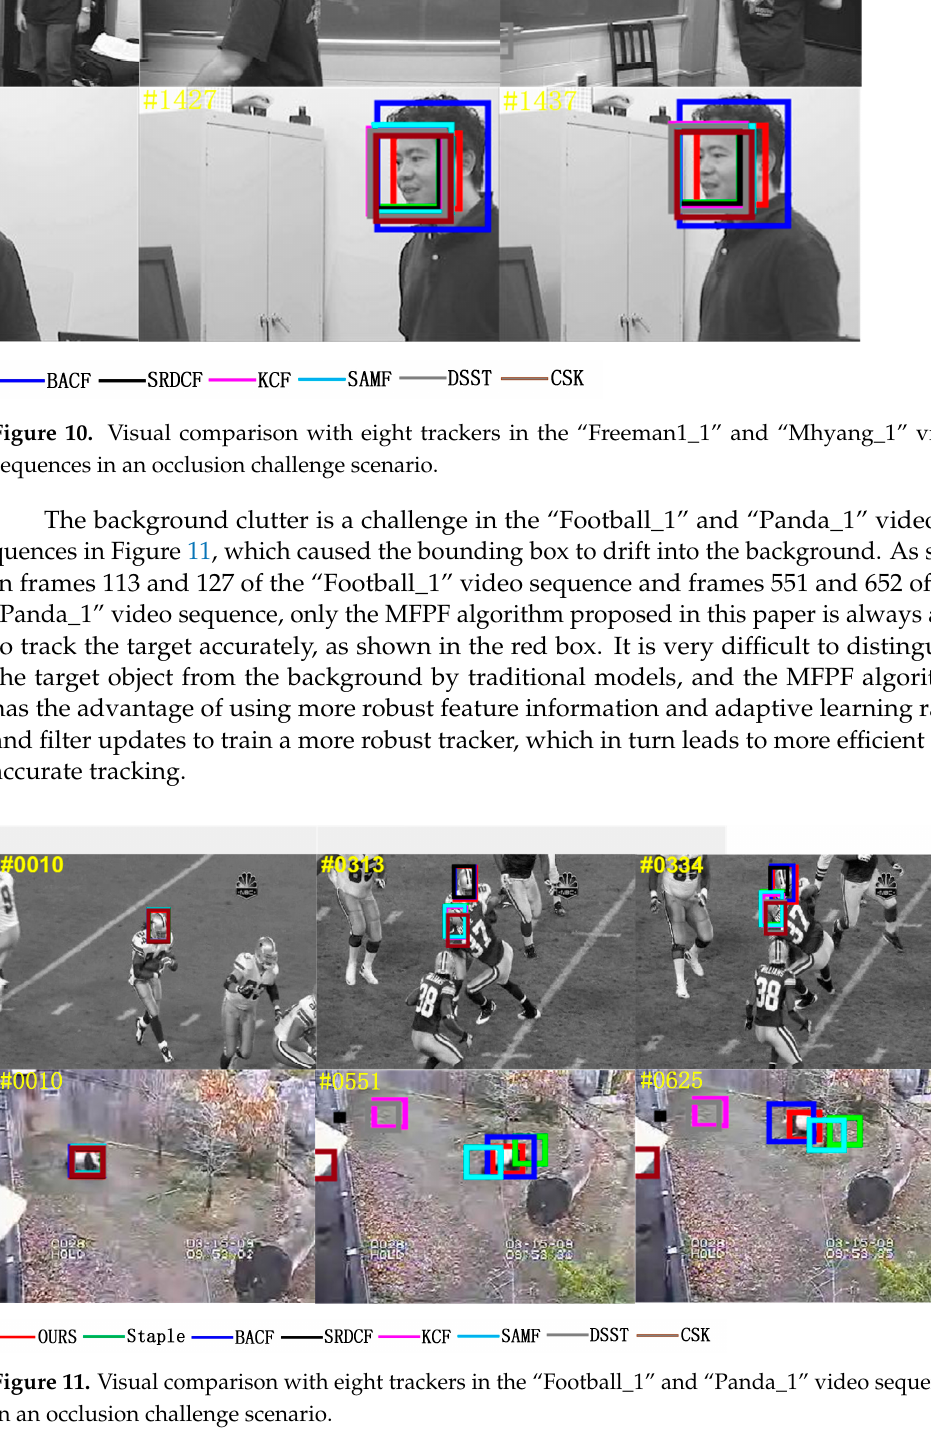
Figure 11. Visual comparison with eight trackers in the “Football_1” and “Panda_1” video se- quences in an occlusion challenge scenario.